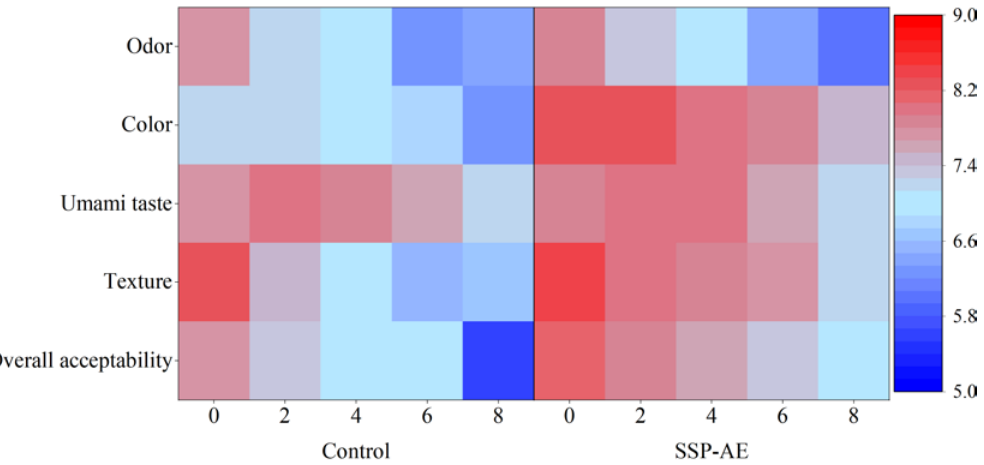
Figure 6. Heatmap of sensory properties of shrimp surimi products with and without astaxanthin extract during frozen storage. SSP-AE: shrimp surimi products with astaxanthin extract addition; control: shrimp surimi products with maize oil only.